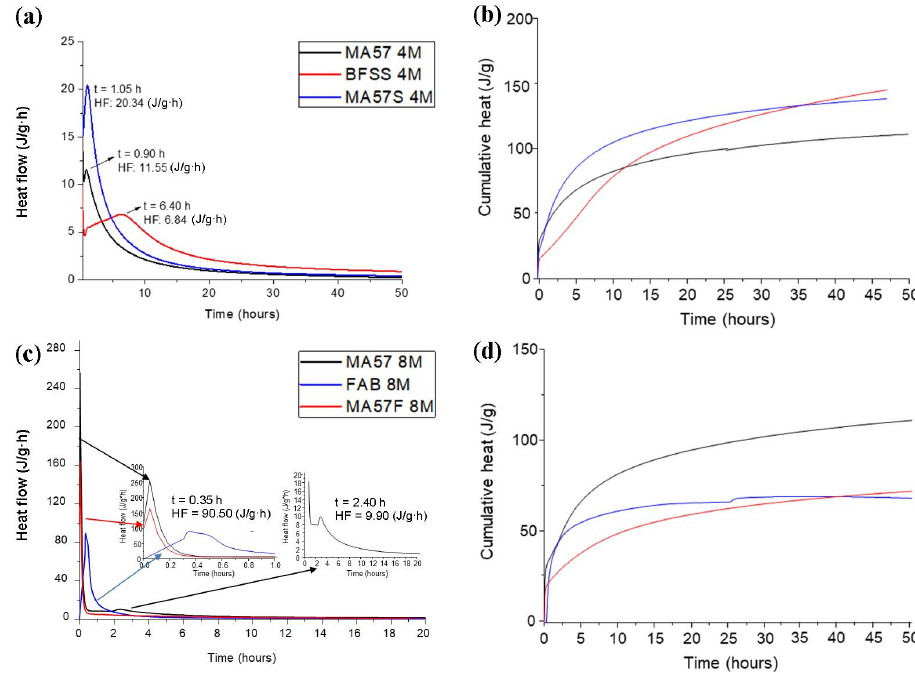
Figure 3. Heat flow ( a , c ) and cumulative heat flow ( b , d ) of pastes activated with 4 M and 8 M NaOH solutions. Legend: t = time; HF = heat flow .